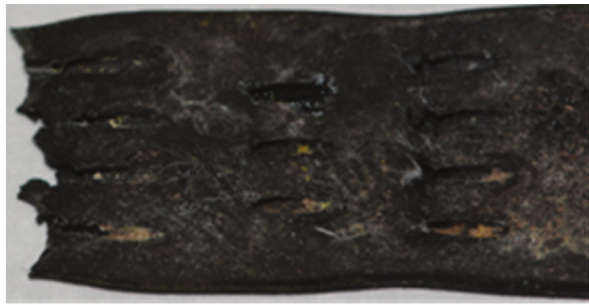
Figure 8: Laser drilling specimens ’ fracture